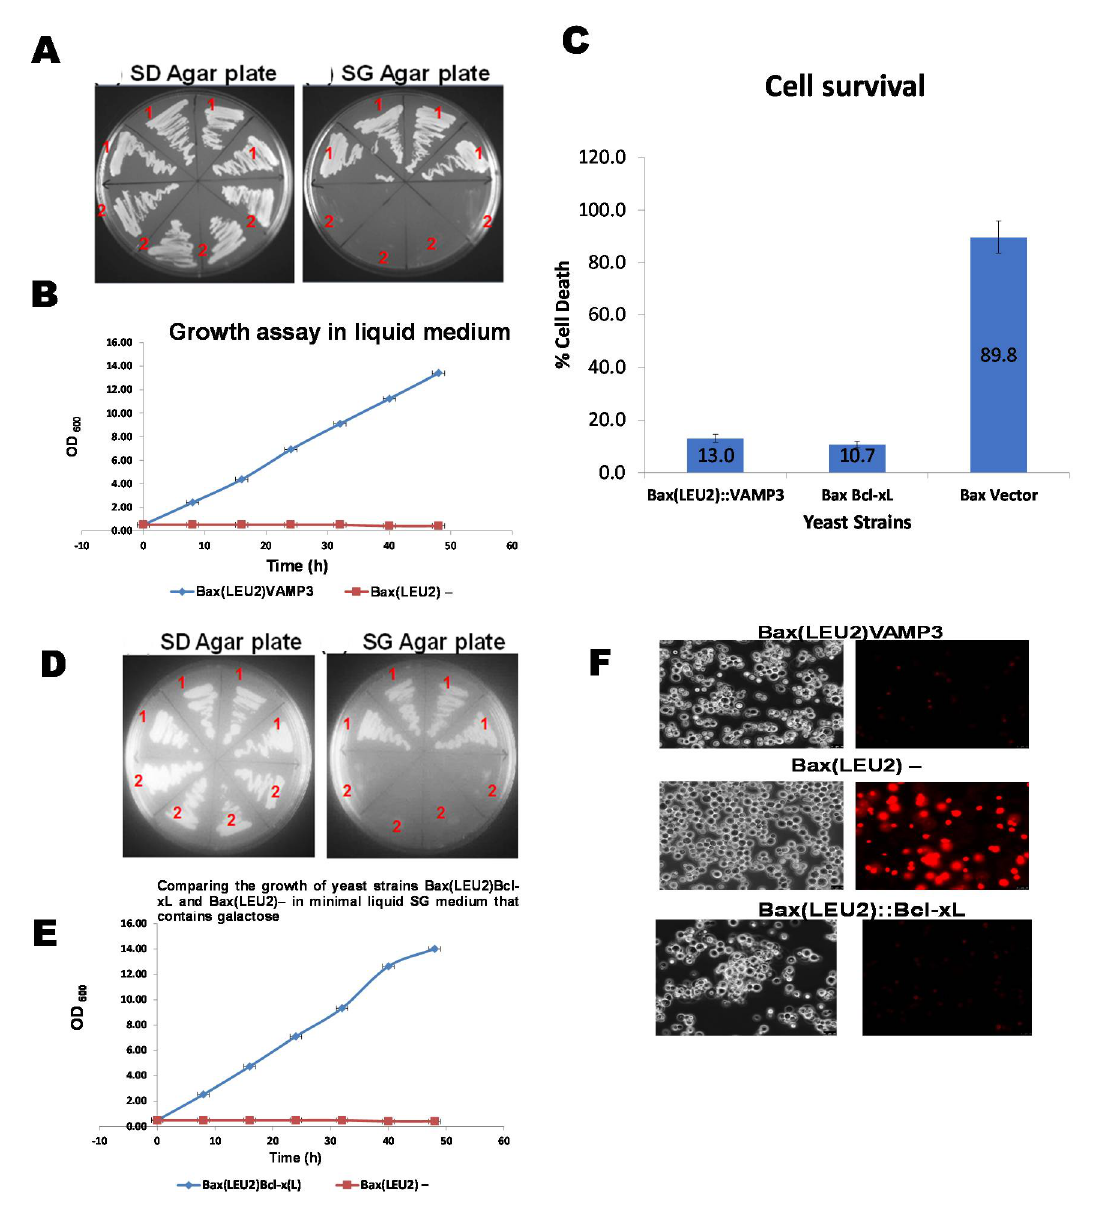
Figure 1. The growth assays on the solid and liquid media and death assay (Phloxin B assay). ( A , D ) Growth of yeast strains in solid agar plates over 72 h, in the glucose-containing minimal medium (S.D.), and galactose containing minimal medium (S.G.). The 4 strains on the upper half of the two plates are Bax(LEU2)VAMP3 ( A ) and Bax(LEU2)Bcl-xL ( D ) transformants (1), containing an episomal 2 µ -plasmid plasmid that encodes the HA-tagged VAMP3 (A) and Bcl-xL ( D ) genes and a Bax expression cassette integrated at the LEU2 locus. The 4 strains, in the lower half of the plates ( A , D ), are Bax(LEU2)–(2) transformants that contain the Bax expression cassette and an empty plasmid. ( B , E ) Growth of yeast cells, Bax + VAMP3 ( B ) and Bax + Bcl-xL ( E ), in the minimal liquid medium containing galactose, throughout 48 h along with the control strain. A two-tailed paired sample t -test shows, statistically, that there was a significant difference ( p < 0.05). ( C ) The percentage of cell death in strains Bax + VAMP3, Bax + Bcl-xL and control Bax(LEU2)–, after growth in galactose for 48 h. The data represent the mean ± S.D. of three independent experiments. Dead cells stained with phloxine B are shown in ( F ) The images on the left a representative of cells under fluorescent light, showing death cells (red). A two way ANOVA test shows that there was a significant difference ( p < 0.05) in cell death between the control strain and each of Bax + VAMP3 and Bax + Bcl-xL strains, but there was no significant difference ( p > 0.05) between Bax + VAMP3 and Bax + Bcl-xL .